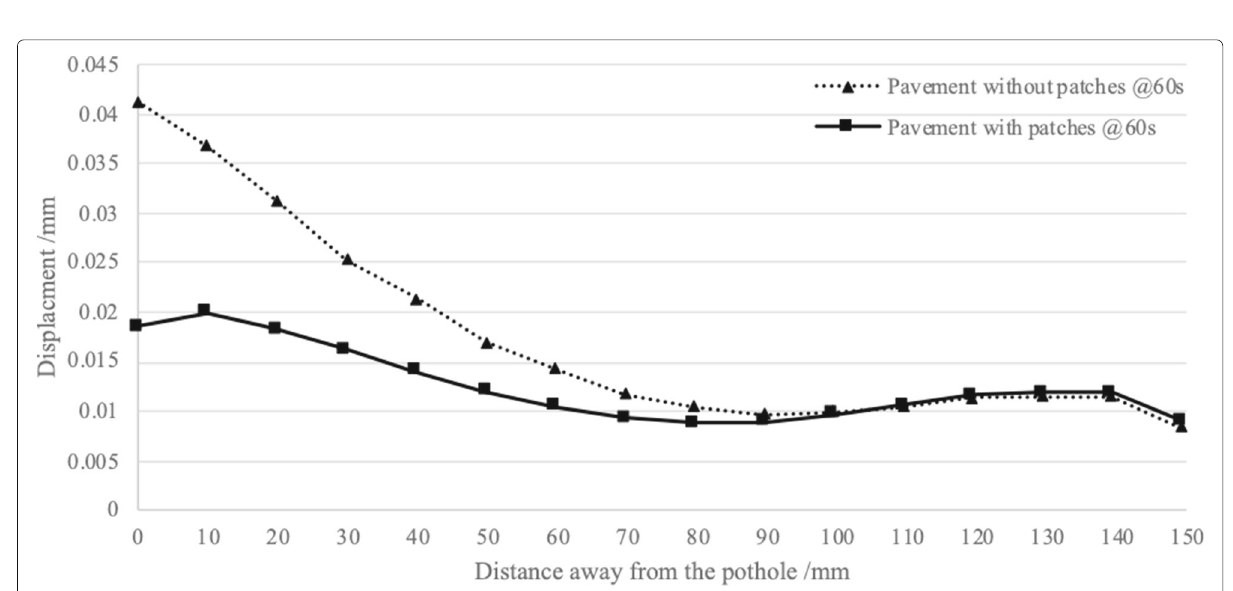
Fig. 6 Time-dependent maximum deformation of the surface layer without and with patches along the edge of model